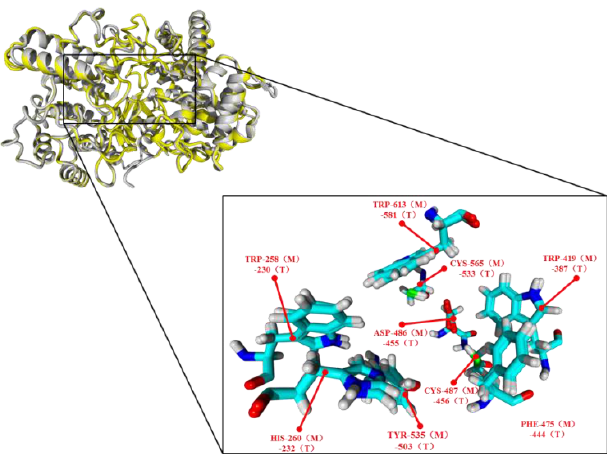
Figure A2. Homology model of cucurbitadienol synthase constructed using the human LAS crystal structure as a template. During optimization of the model no major structural changes were observed for active site residues, and refinement consisted only on fine-tuning the coordinates of active site sidechain atoms.